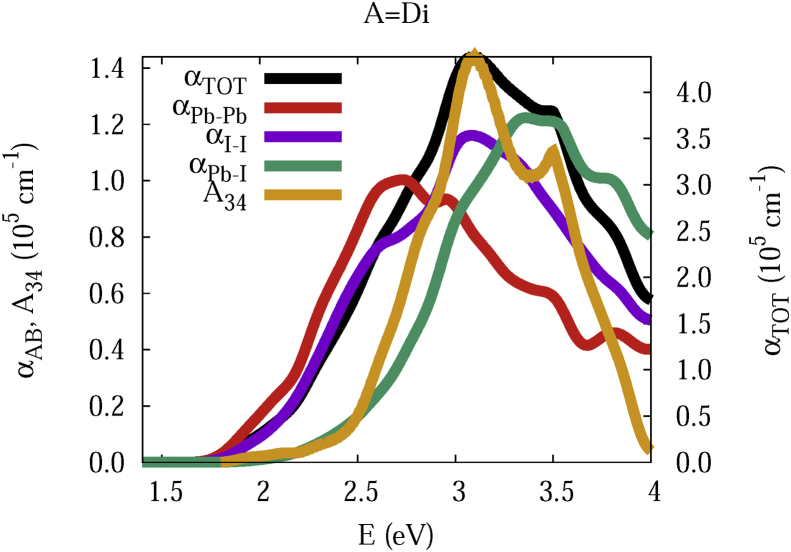
Same legend as that in Fig. 1, but for A = Di.